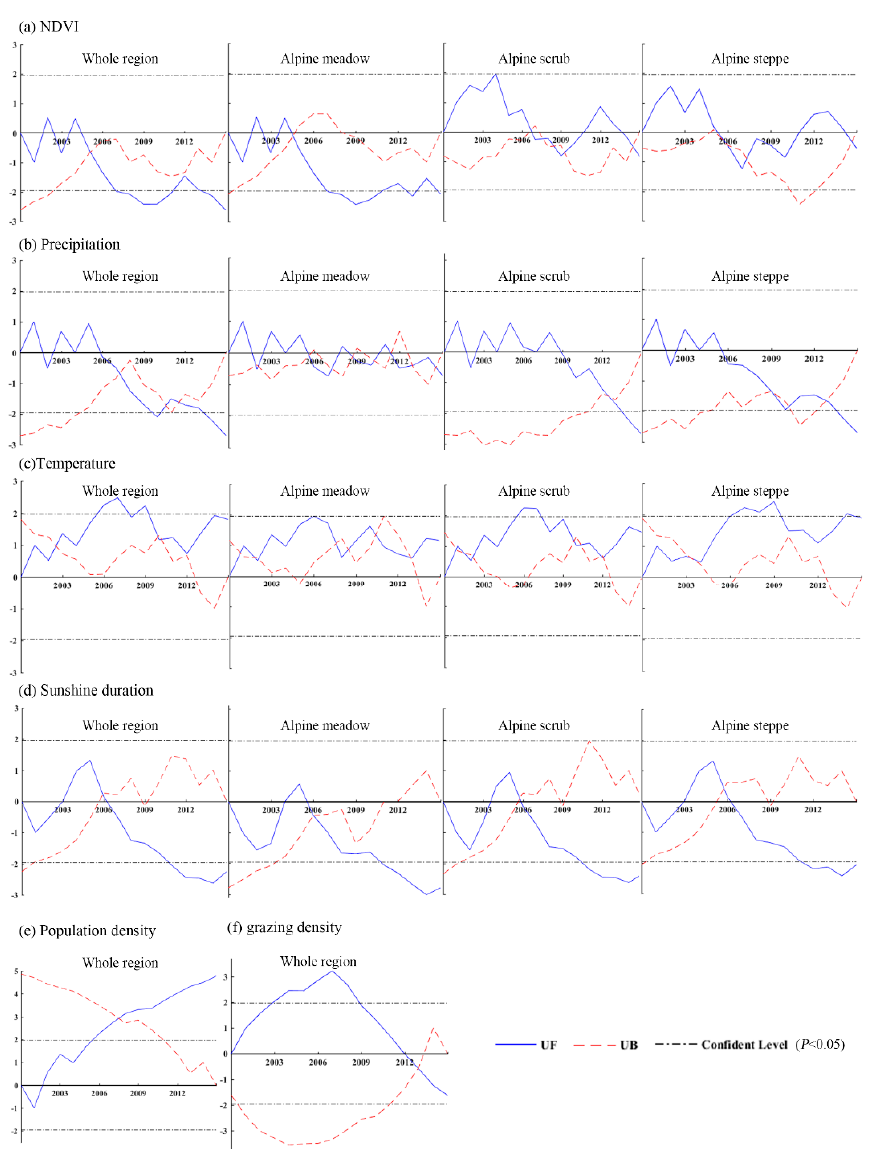
Figure 5. The MANN ‐ KENDALL test to detect the annual trends of environment factors during 2000– 2015. The trends of ( a ) NDVI, ( b ) Precipitation, ( c ) Temperature and ( d ) Sunshine duration are shown at four scales, that is, the whole region, the alpine meadow, the alpine scrub and the alpine steppe. The trends of ( e ) Population density and ( f ) Grazing density are only exhibited at the scale of the whole region, and trends at county scale are shown in appendix Figure A1.